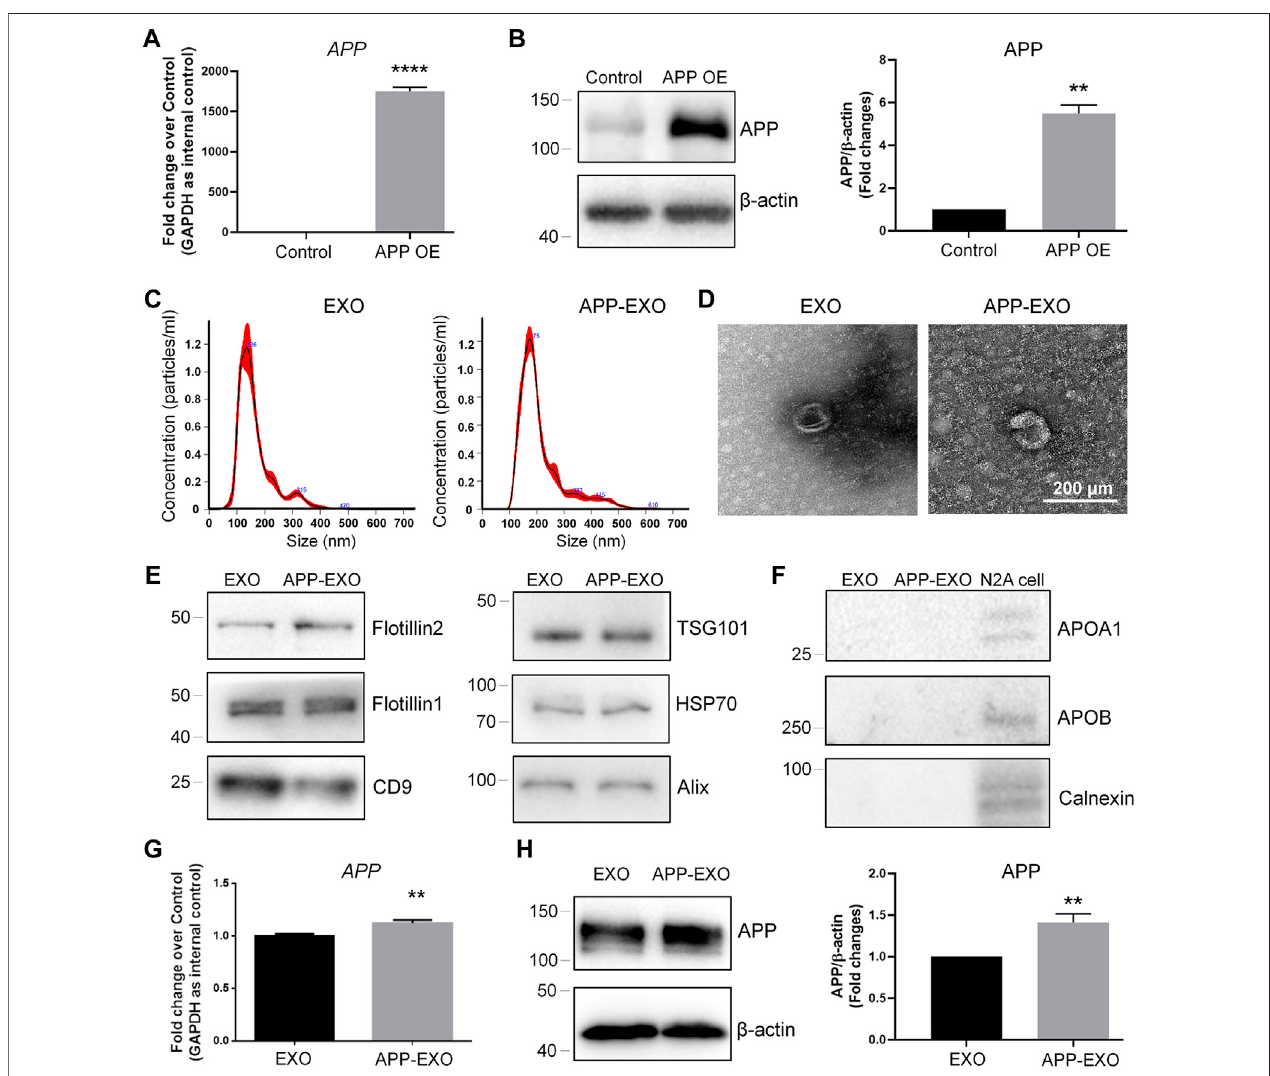
FIGURE 2 | APP-EXO promote APP expression in recipient cells. (A,B) N2a cells were transfected with either control vector or APP OE plasmid for 2 days. The expression levels of APP transcripts and APP proteins were determined by RT-qPCR (A) and western blotting (B) , respectively. (C) Particle-size distribution and concentration of exosomes were determined by NTA. (D) EXO and APP-EXO were visualized under TEM using negative staining. (E) The expression levels of exosome positivemarkersFlotillin2,Flotillin1,CD9,TSG101,HSP70,andCD9inproteinlysatesofexosomesweredeterminedbywesternblotting. (F) Theexpressionlevels ofexosome negativemarkersApoa1,Apob,and Calnexin inproteinlysates ofexosomesweredetermined bywesternblotting. (G) The APP transcriptlevels inN2a cells co-cultured with APP-EXO or EXO were determined by RT-qPCR. (H) The APP protein levels in N2a cells co-cultured either APP-EXO or EXO were determined by western blotting. Data were represented as mean ± s. d. from three independent experiments. ** and **** denote p < 0.01 and p < 0.0001, respectively.